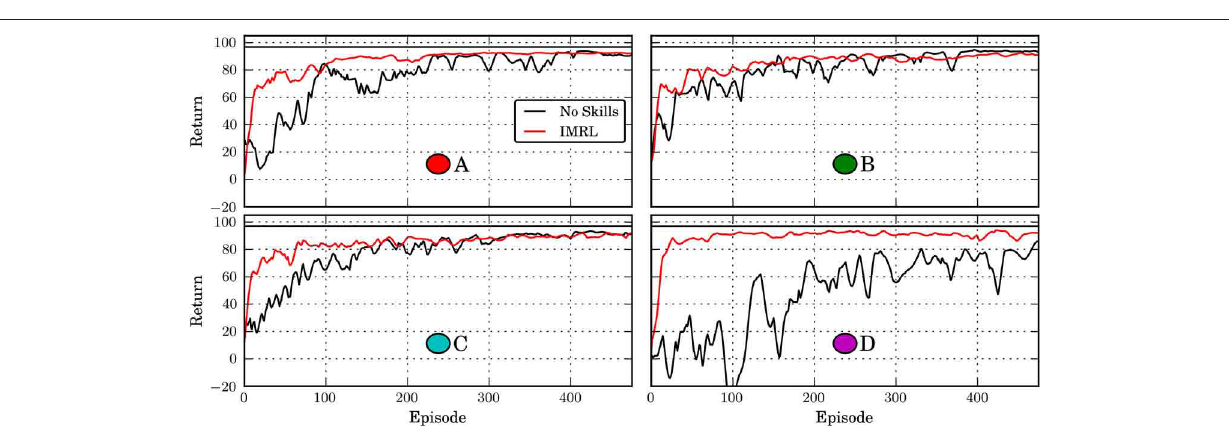
FIGURE 10 | Return of IMRL agent in the Octopus domain under the “novelty” motivation after 50,000 developmental steps. The circle patches indicate the respective targets used in the runs (compare Figure 8 ). “No Skills” shows the performance of an agent that does not learn skills and